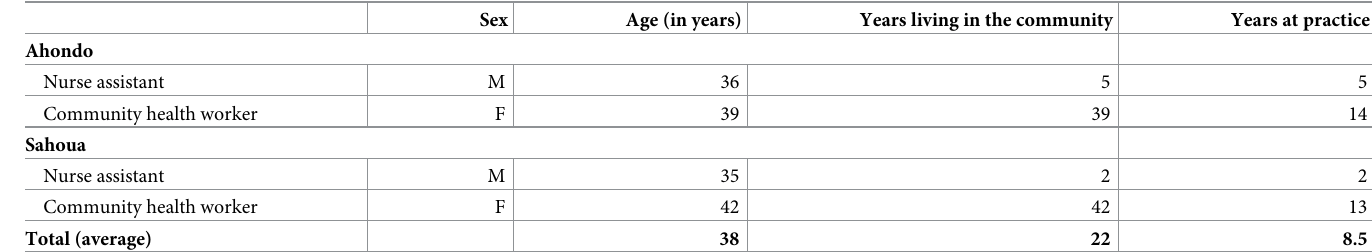
Table 2. Demographic characteristics of health care workers ( n = 4) included in this study from south-central Coˆte d’Ivoire in late 2021/early 2022.